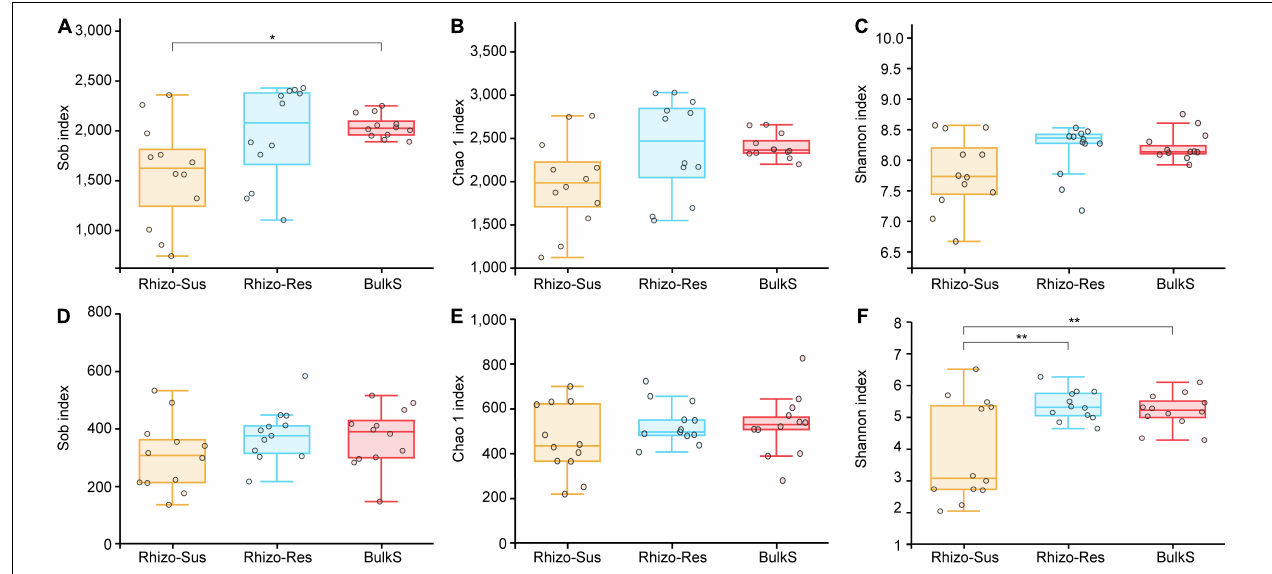
FIGURE 1 | Box plots of bacterial (A–C) and fungal (D–F) Sobs and Chao 1 and Shannon index in disease susceptible C. oleifera rhizosphere (Rhizo-Sus, yellow), disease resistant C. yuhsienensis rhizosphere (Rhizo-Res, blue), and bulk soil (BulkS, red). The line in the box indicates the median of each compartment. The line over and below the box indicates the maximum and minimum value, respectively. The top and bottom line of the box indicates the upper and lower quartile, respectively. The circles indicate each sample. The * and ** over the boxes indicate the significant differences based on Tukey’s HSD test among compartments at p < 0.05 and p < 0.01,